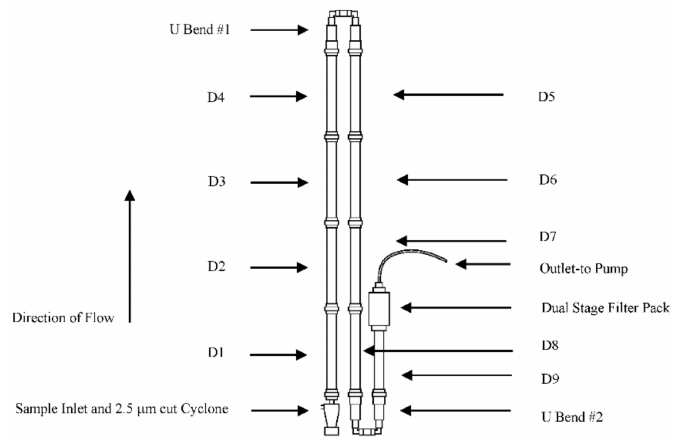
Figure 2. Nine Annular Denuder System Set-Up (9-ADS) used in previous measuring campaigns at poultry housing facilities